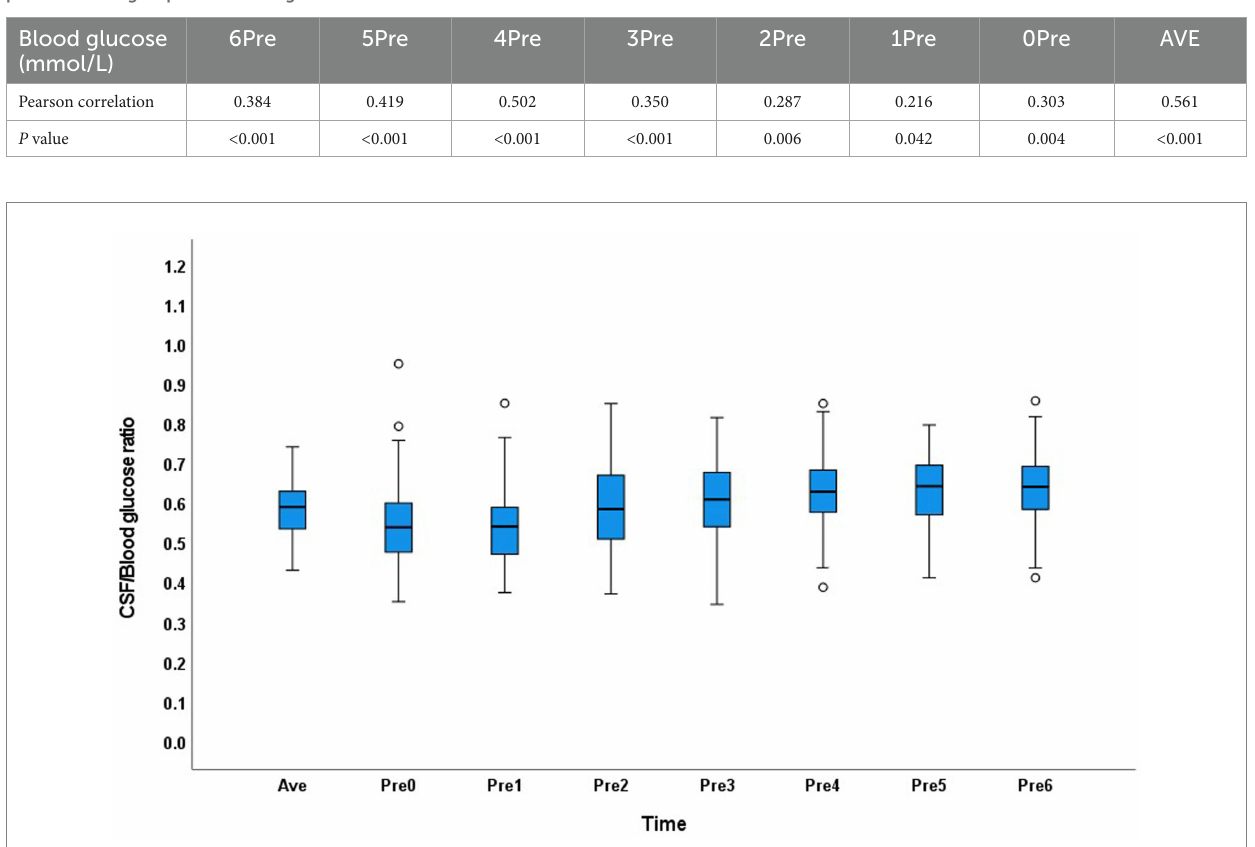
FIGURE 1 Distribution of the cerebrospinal fluid/blood glucose ratio at each time point and the average value in the normal glucose metabolism